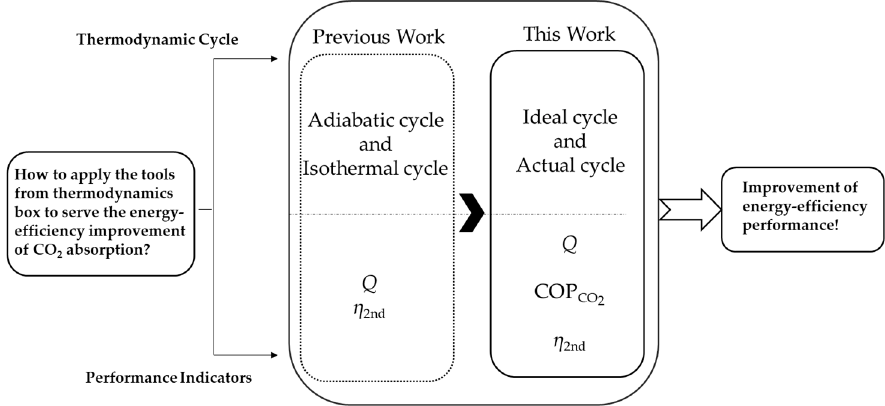
Figure 2. Comparison of thermodynamic frameworks of previous works and this work.